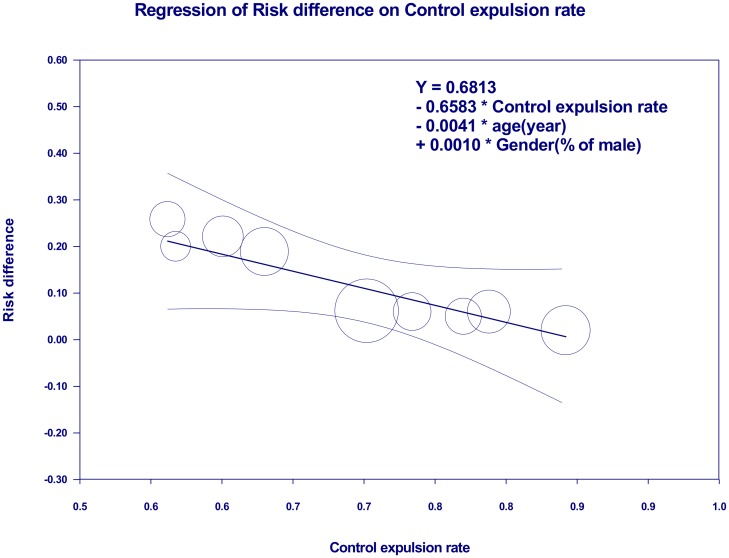
Meta-regression for the risk difference (RD) of stone expulsion rates between silodosin and tamsulosin.The RD was proportional to the control expulsion rate.